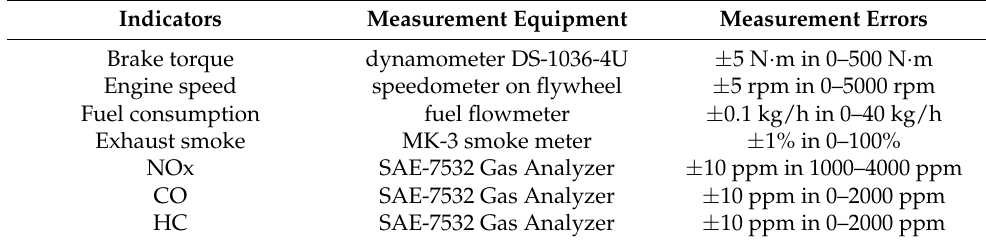
Table 3. Measurement equipment and measurement